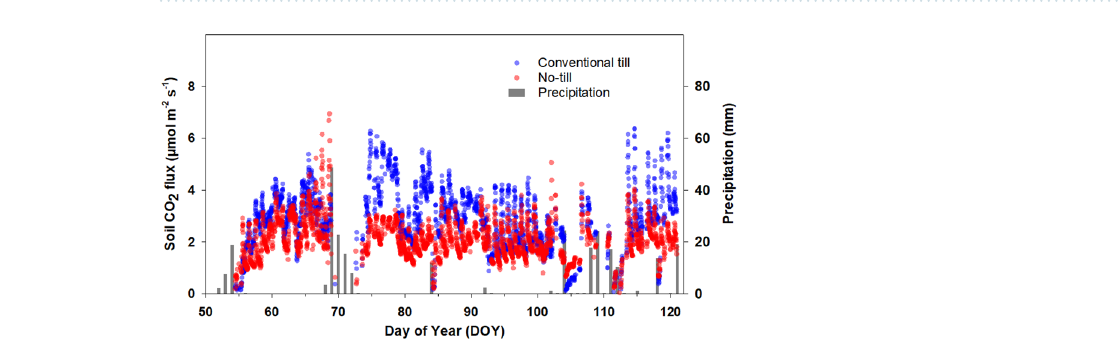
Figure 3. Daily volumetric soil water content (VWC) measured at 5, 10 and 20 cm depths in (A) wheat and (B) soybean under conventional tillage and no-tillage.